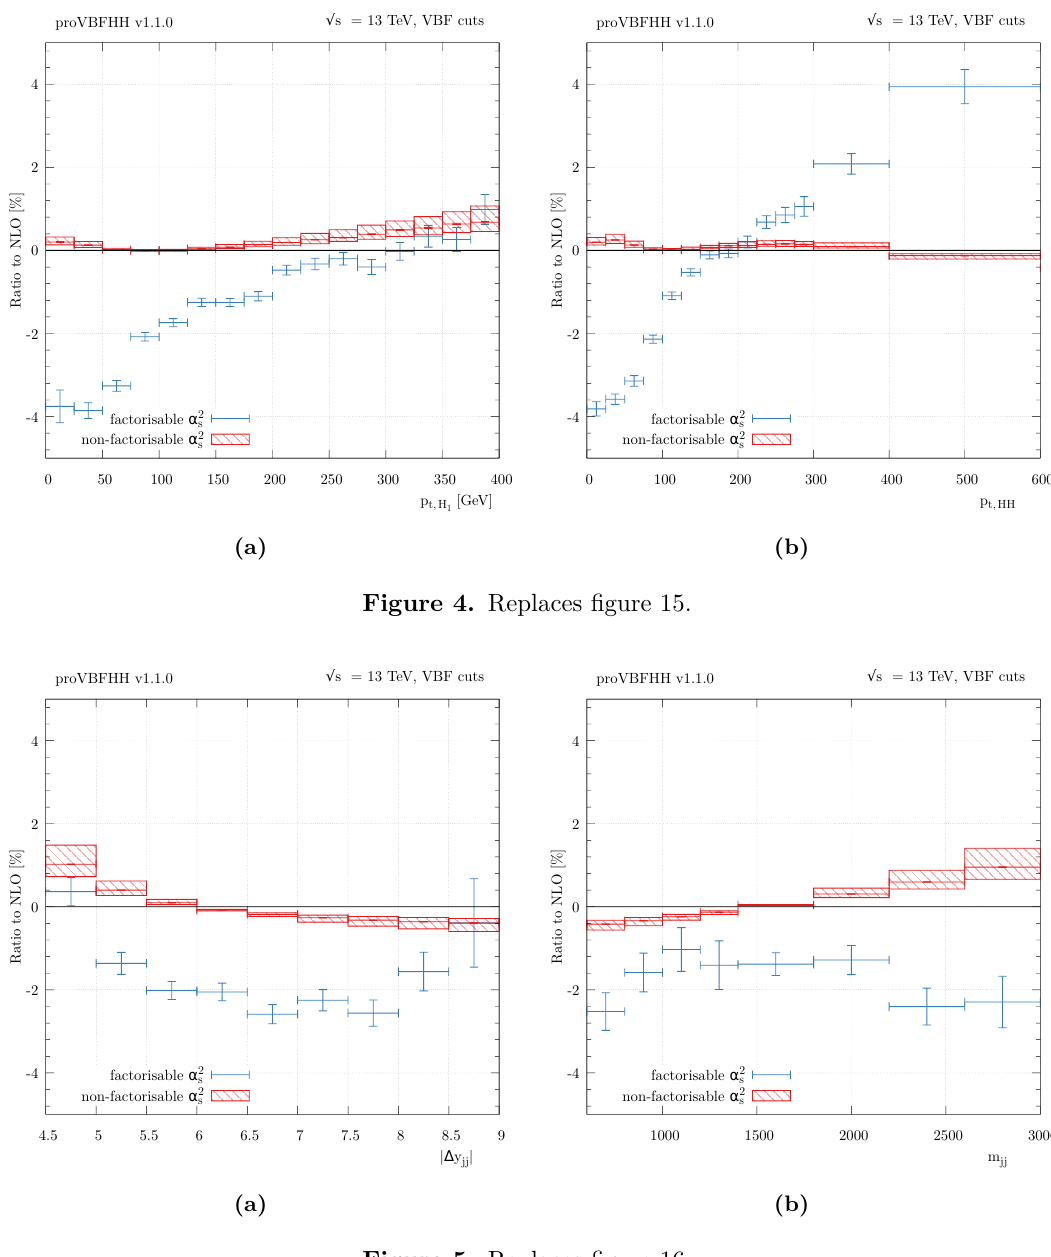
Figure 5. Replaces figure